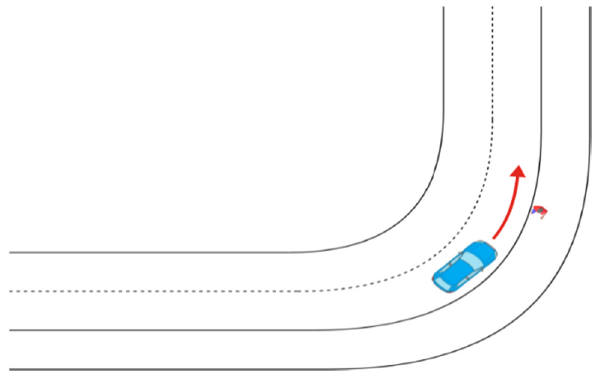
Figure 12: Research situation in test 4. Source: “ authors ” own research.